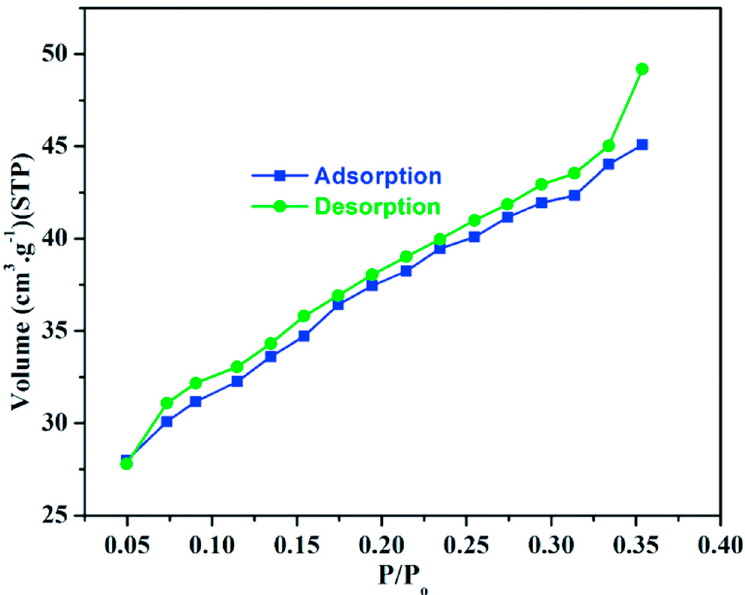
Figure 21. Nitrogen adsorption–desorption isotherm spectrum of cerium bentonite clay-malic acid chitosan (CeBCA@CS) adsorbent. Reproduced with permission from Reference [151]. Open Access 2020, RSC Advances.